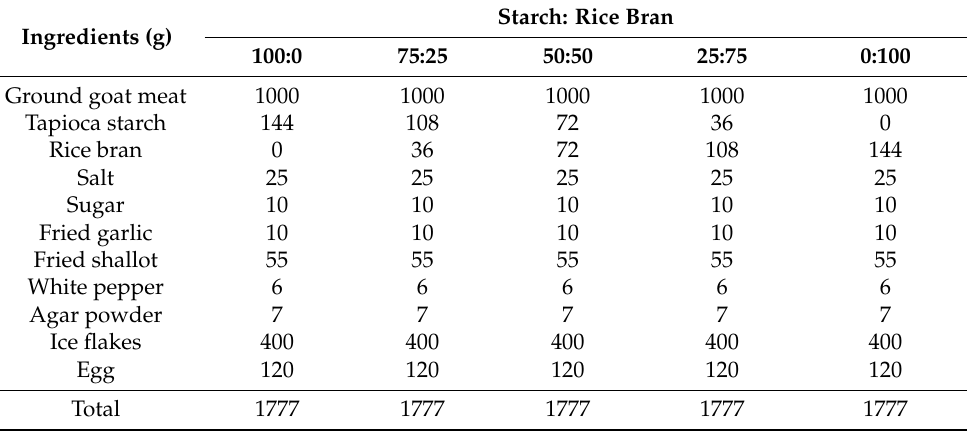
Table 2. Recipe for goat ‘bakso’ meatballs with different ratios of tapioca starch to rice bran. Ingredients